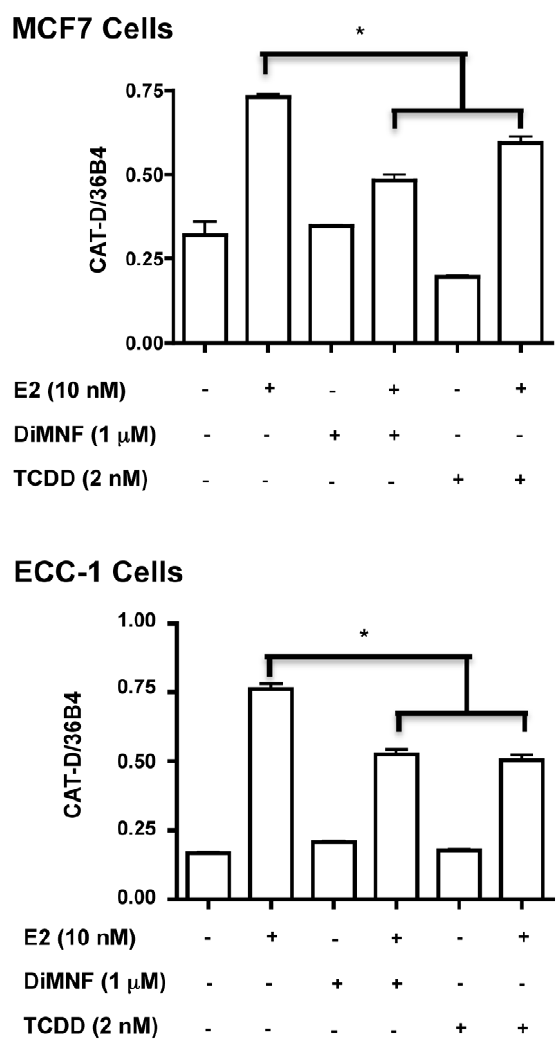
Figure 4. Effect of selective aryl hydrocarbon receptor modulators on estrogen-inducible transcription. The effect of 1 m M DiMNF on E2-inducible CAT-D expression in MCF7 and ECC-1 cells. Cells were treated with the indicated ligands for 24 h prior to RNA isolation. Gene expression was determined as described above. Error bars represent 6 S.D. * p ,